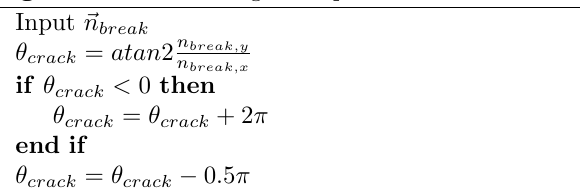
Algorithm 7 Crack angle computation in 2D.